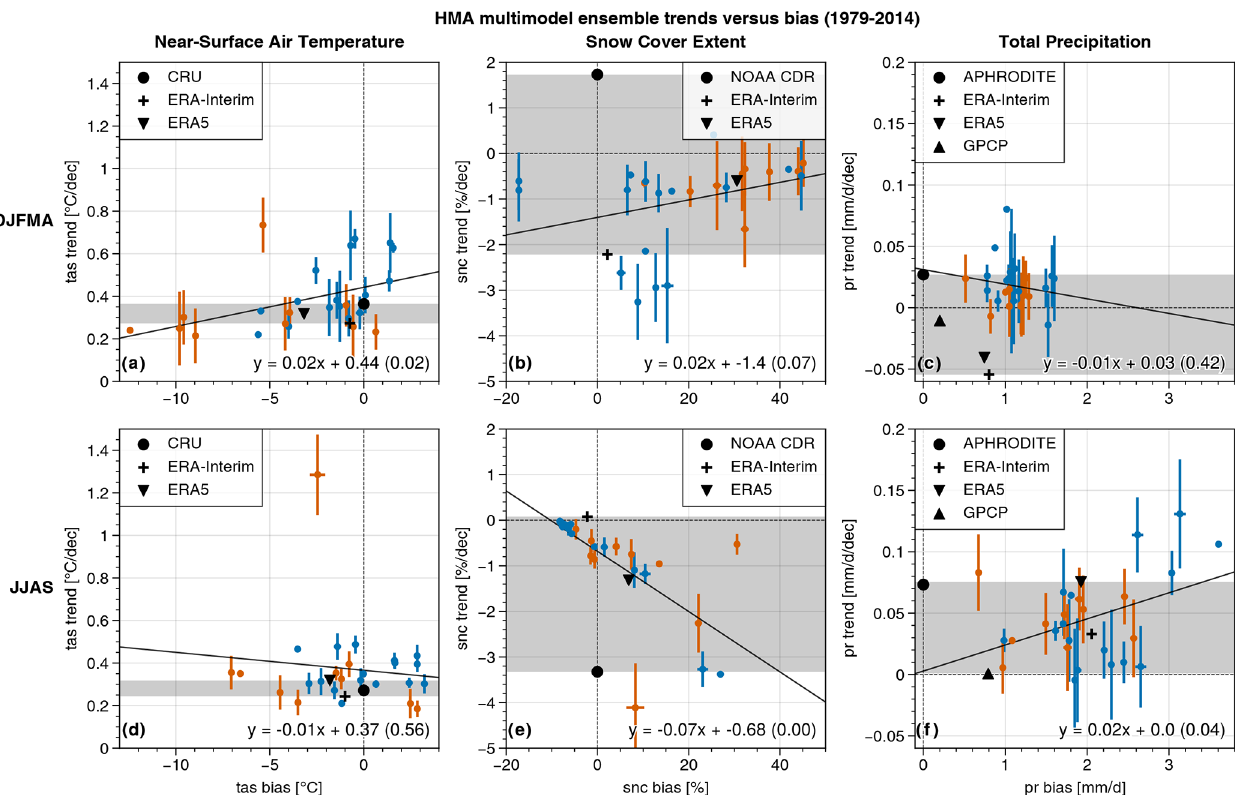
Figure 8. Seasonal (DJFMA and JJAS) HMA multimodel ensemble trends versus model biases over 1979–2014 for temperature (a, d) , snow cover (b, e) and precipitation (c, f) . Vertical (horizontal) bars correspond to the standard deviation of the trends (biases) of the ensemble members for each model (the number of members differs among the models Table A1). Observation and reanalysis datasets are shown with black symbols. The 10 models used for projections are shown in orange, while other models are shown in blue. The gray shading represents the range of observation trends. The solid black line corresponds to a linear regression from the multimodel mean values (including all models) with the p value shown in brackets following the equation at the bottom right of each panel. The light horizontal (vertical) dashed lines correspond to a null trend (null bias with respect to the reference observation